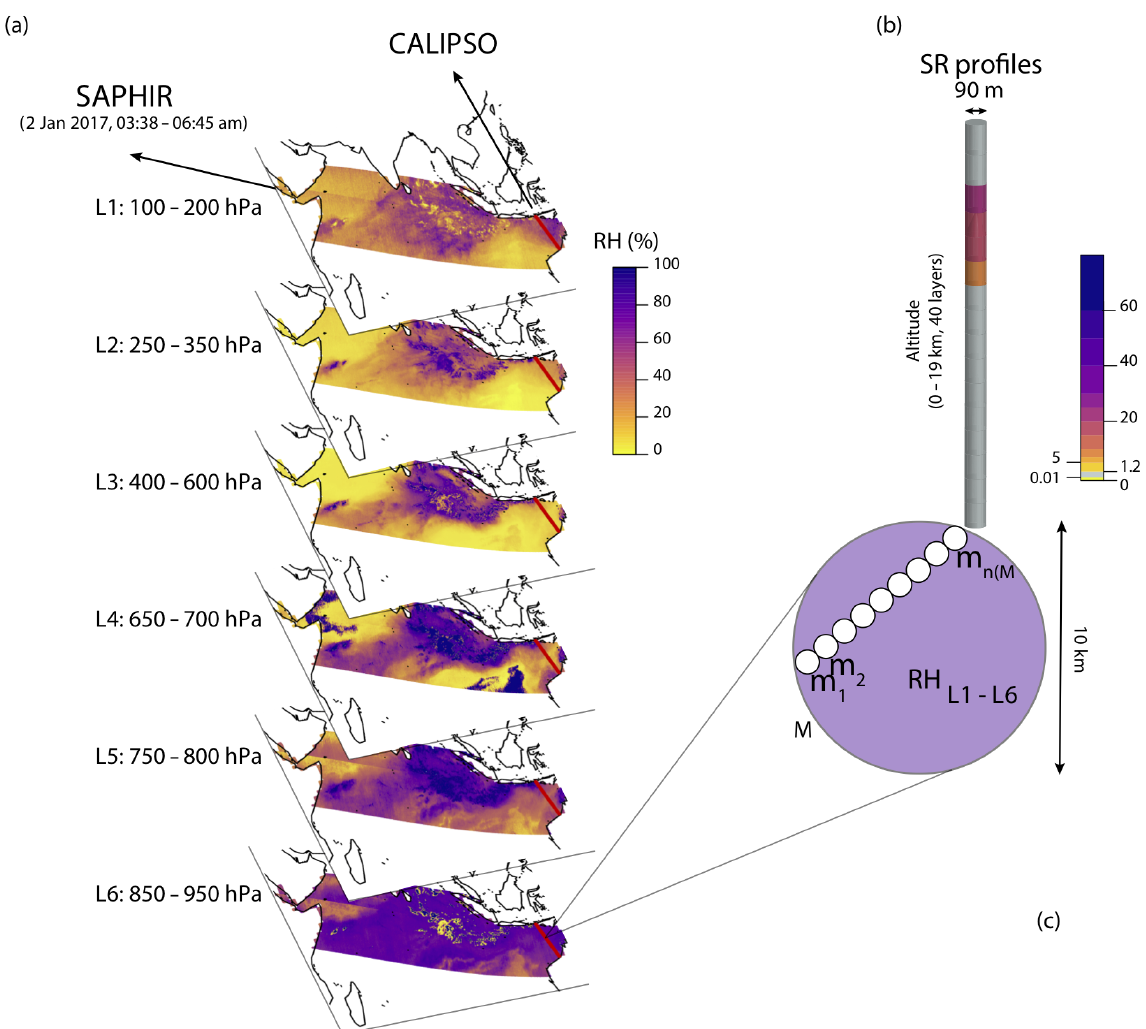
Figure 1. (a) : RH (mean) observed by SAPHIR for all six pressure layers in the Indian Ocean on 2 January 2017 between 03:38 and 06:45UTC. Overlaid is the CALIPSO track line (red line). (b) : example of the SR profile measured by CALIPSO. (c) : schematic represen- tation of SAPHIR–CALIPSO co-location: M = 1 ,...,N SAPHIR measurements at coarse resolution encapsulating m = 1 ,...,n ( M ) finely resolved CALIPSO